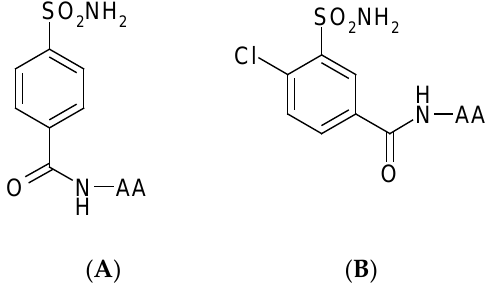
Figure 1. ( A , B ) Sulfonamides incorporating benzamide moieties, amino acid (AA) and dipeptide AA moieties [1,2].